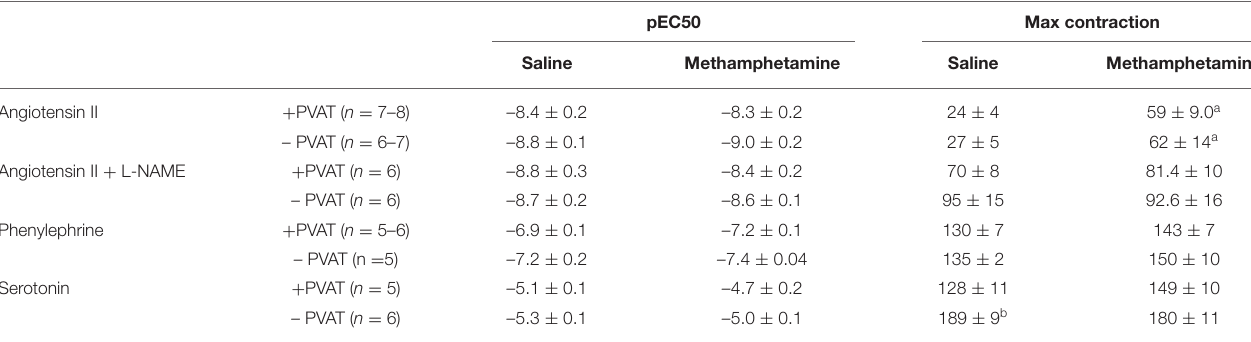
TABLE 3 | Angiotensin II, phenylephrine, and serotonin-induced contractile responses in aortas isolated from adult male rats that were exposed to fetal saline or methamphetamine (5 mg/kg/day) throughout the gestational period.